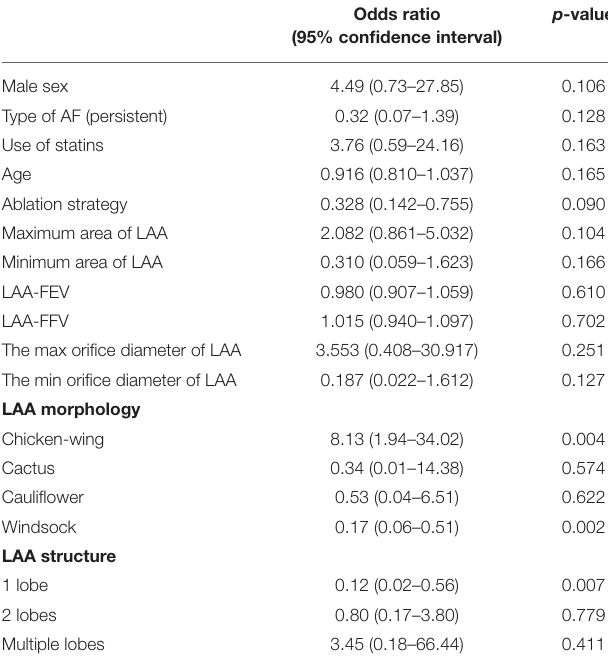
Odds ratio (95% confidence interval)